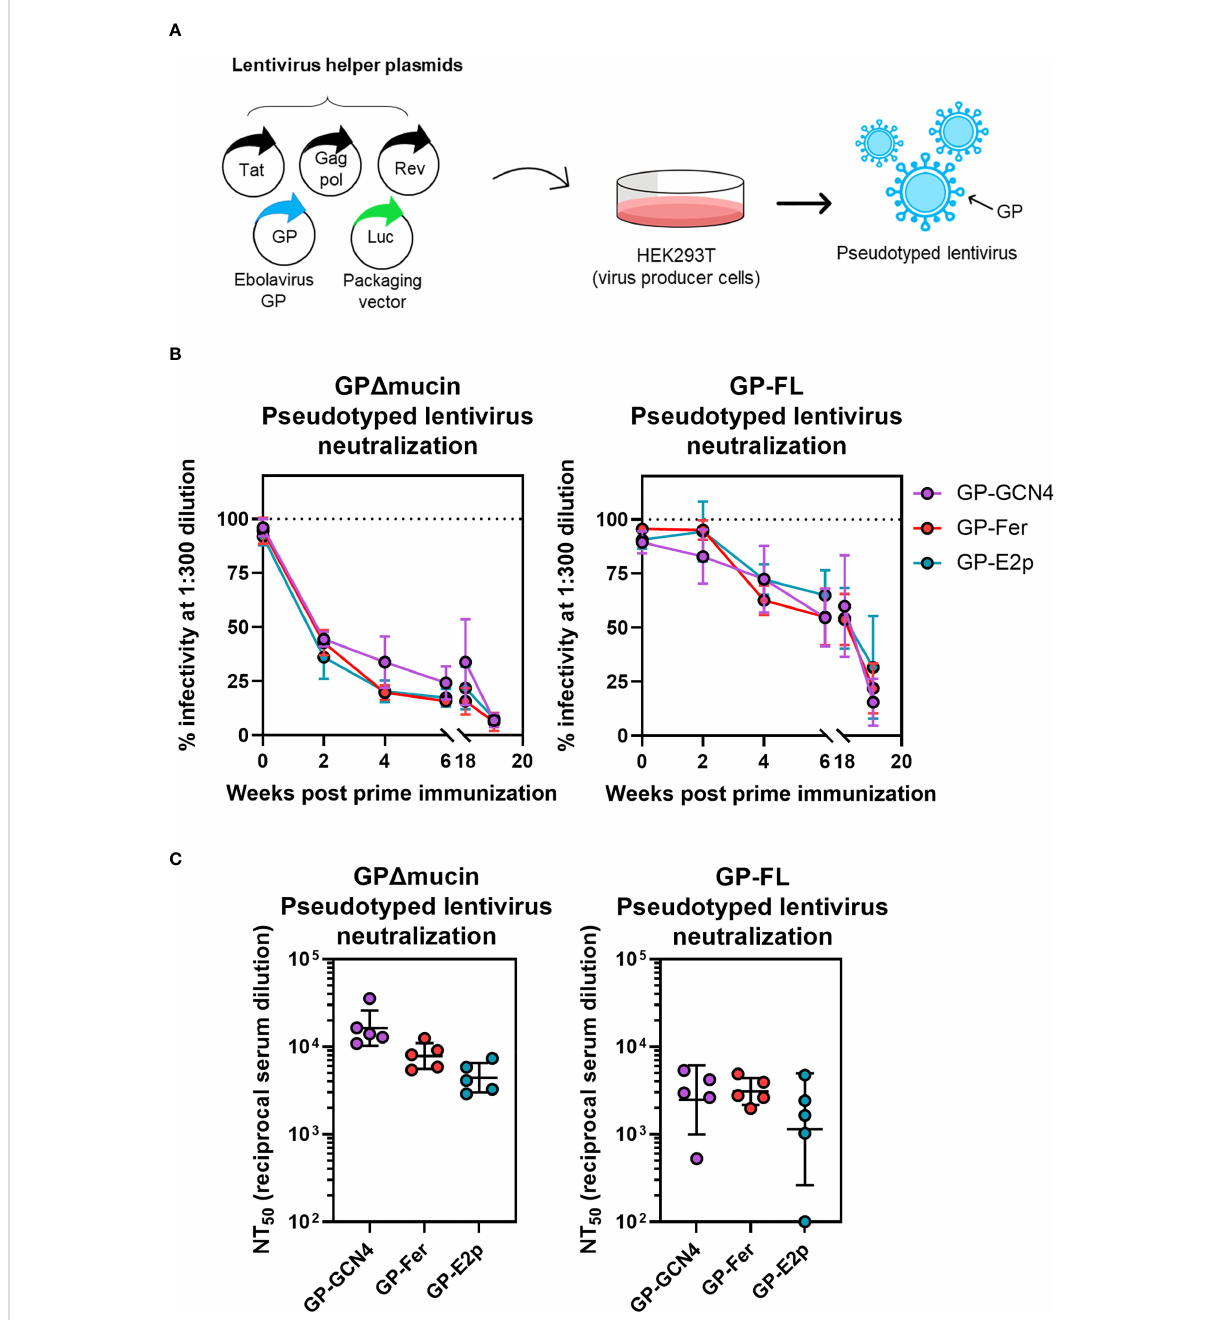
FIGURE 4 Sera from mice immunized with GP D mucin antigens neutralize GP-pseudotyped lentiviruses. (A) Lentiviruses pseudotyped with GP D mucin were produced by transfecting a lentiviral packaging vector as well as plasmids expressing lentiviral helper proteins and GPs into HEK239T cells. Viruses were harvested from HEK293T supernatant and used to assess viral entry inhibition via expression of a luciferase reporter gene. (B) Viral neuralization of both GP D mucin and FL GP pseudotyped viruses was assessed at a single dilution point (1:300) with serum collected at weeks 2, 4, 6, 18, and 20 post prime immunization. Each point represents the mean % infectivity in the presence of 1:300 serum dilution for each group at each time point and error bars represent the standard deviation. (C) Final bleeds were assessed for neuralization of both GP D mucin and FL GP pseudotyped viruses using a 6-point dilution series. Dilution curves were fi t to obtain NT 50 values; each point represents the average NT 50 for a single mouse, the line represents the geometric mean per group, and error bars represent the geometric standard deviation. Statistical analysis was performed using ordinary one-way ANOVA with Tukey ’ s multiple comparisons test and no statistically signi fi cant differences were found between the three antigen